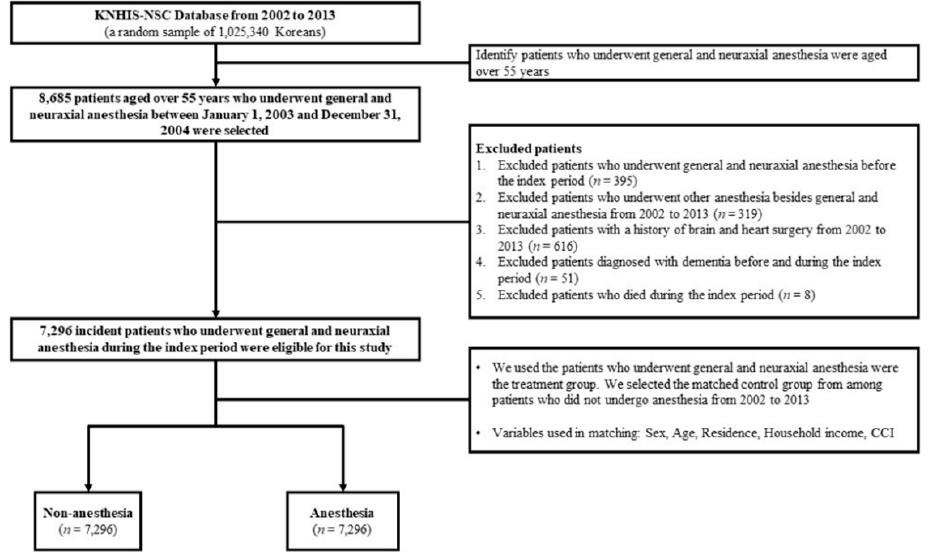
Figure 1. Flow chart of study design. CCI—Charlson comorbidity index.